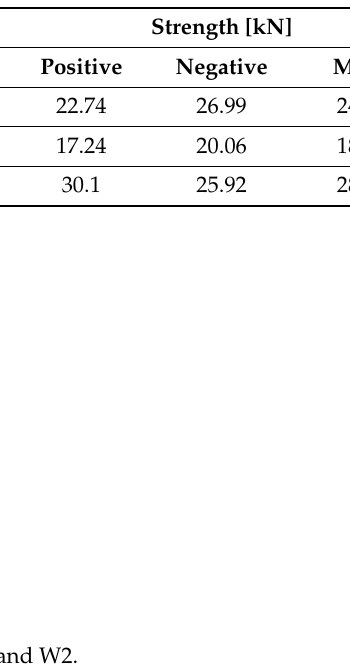
Figure 23. Stiffness degradation of specimens W0, W1, and W2. Figure 24. Cumulative dissipated energy of Specimens W0, W1, and W2.